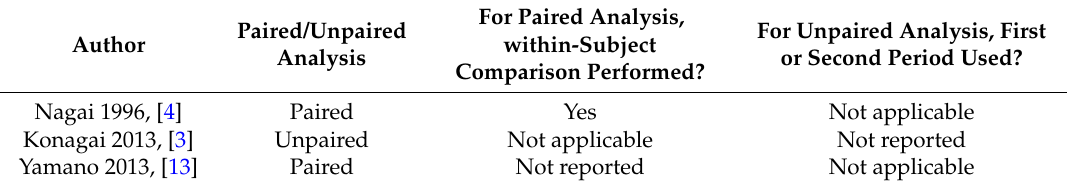
Table 2. Study design of cross-over trials.